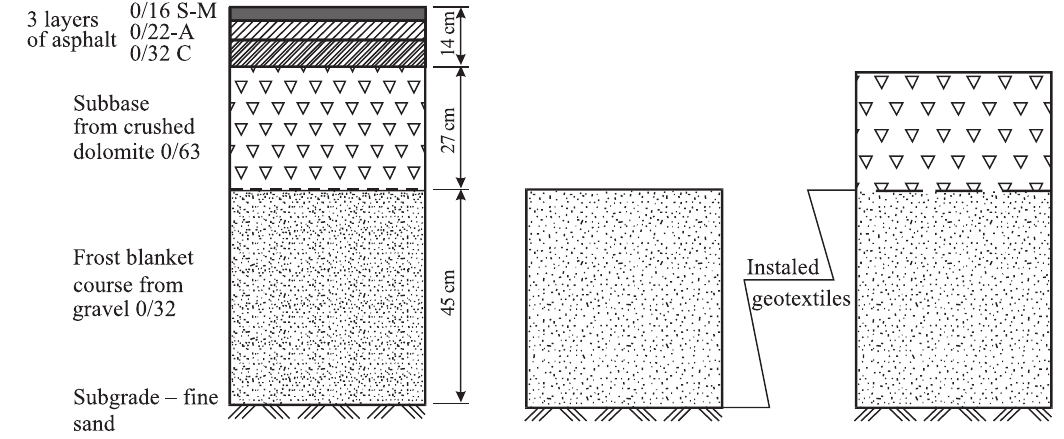
Fig. 1. Road pavement structure and the levels of geotextile installation: a ‒ road pavement structure; b ‒ geotextile separating the subgrade and the frost blanket course; c ‒ geotextile separating the frost blanket course and the